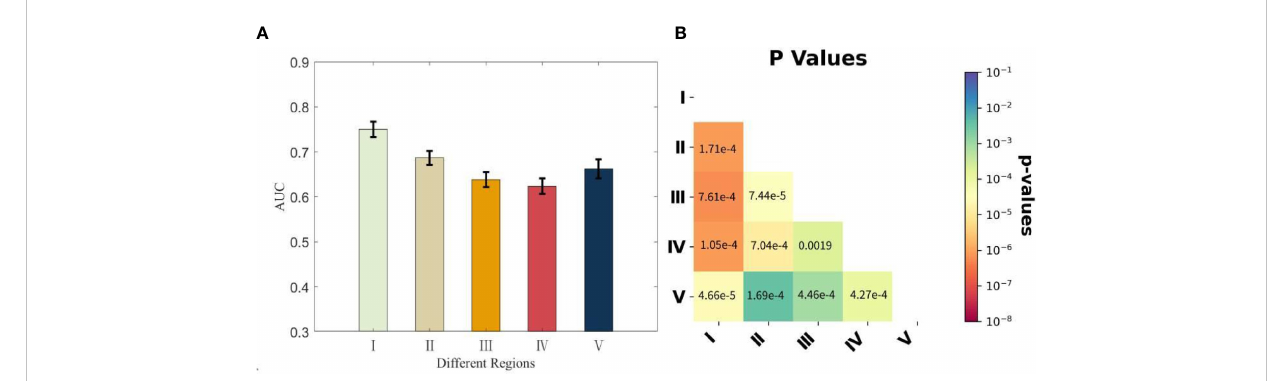
FIGURE 4 The AUC values calculated from the fi ve subdivided datasets with nodular regions separately perturbed by noises and the associated p-value matrix for statistical comparisons. (A) Each bar representing the corresponding region is presented with the average AUC values over the fi ve subdivided datasets and the standard deviations. (B) All p-values were<0.004, and self-comparisons were omitted, as they were constant at 1. AUC, area under the curve.